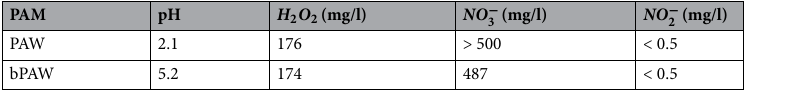
Table 1. PAW is deionized water activated by cold atmospheric plasma and bPAW is a solution of 90% of PAW buffered with 10% of PBS10X in volume.